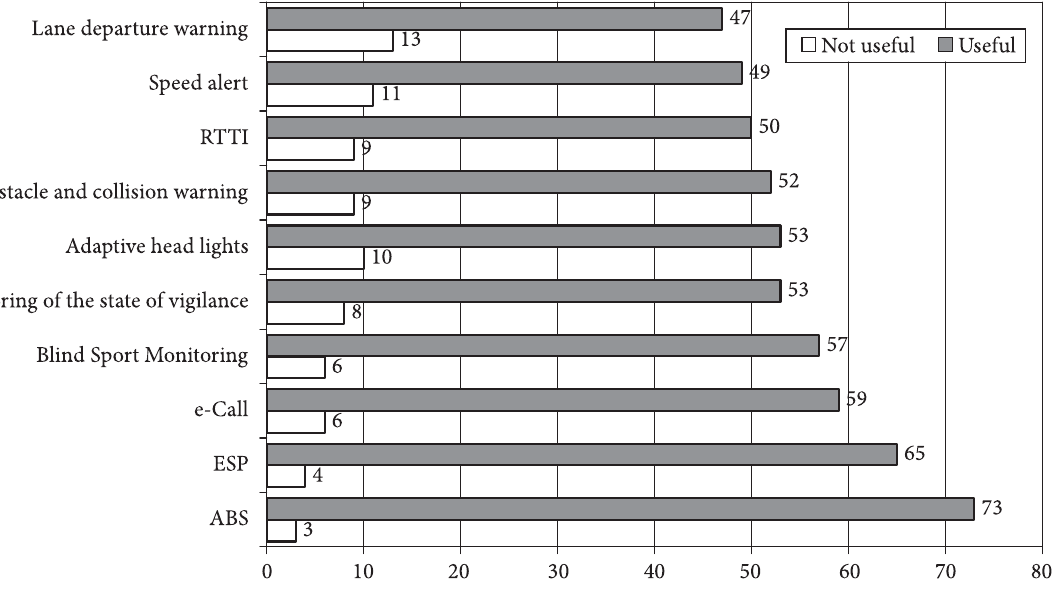
Fig. 5. How drivers perceive IVSS